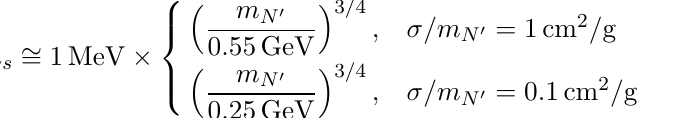
N 0 (dashed, solid black, dotted) and the s versus m s N 0